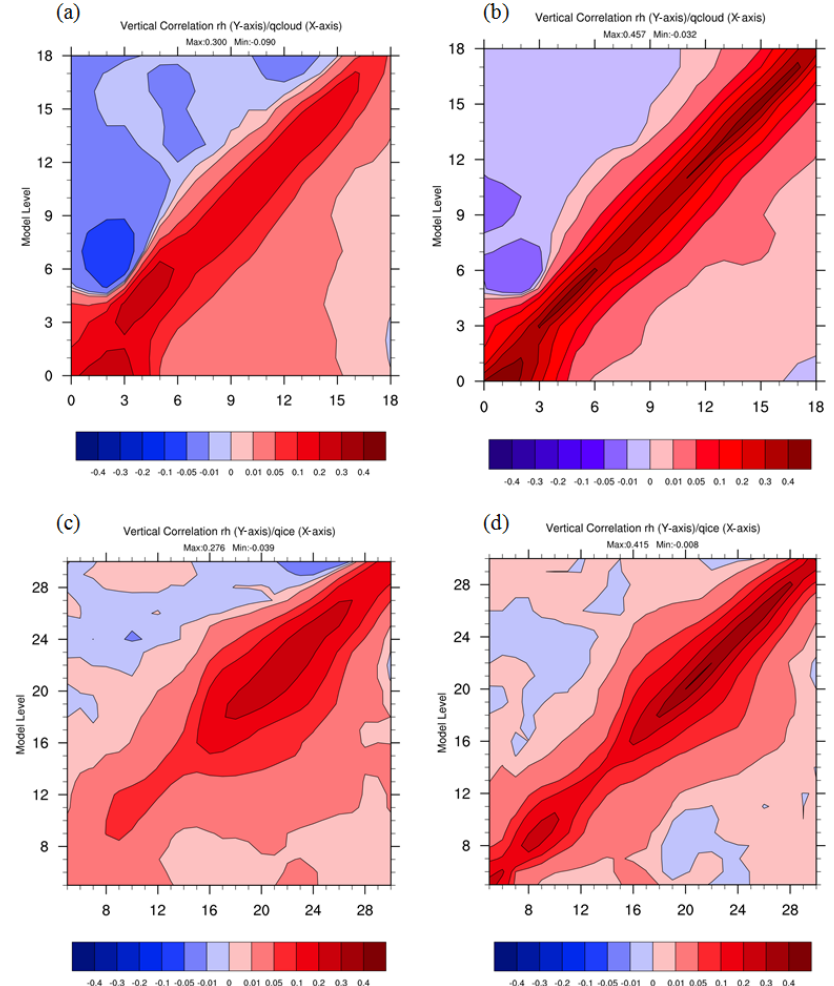
Figure 14. (a) Raw vertical cross-correlations between the cloud mixing ratio ( q cloud ) and relative humidity (RH), (b) filtered vertical cross- correlations between q cloud and RH, (c) raw vertical cross-correlations between the ice mixing ratio ( q ice ) and RH, and (d) filtered vertical cross-correlations between q ice and RH. Taking into account the perturbations coming from the transition of a cloudy to a non-cloudy area only when reaching the threshold mixing ratio of 10 − 6 kgkg − 1 , this intensifies the vertical correlation (WRF, res. 15km,